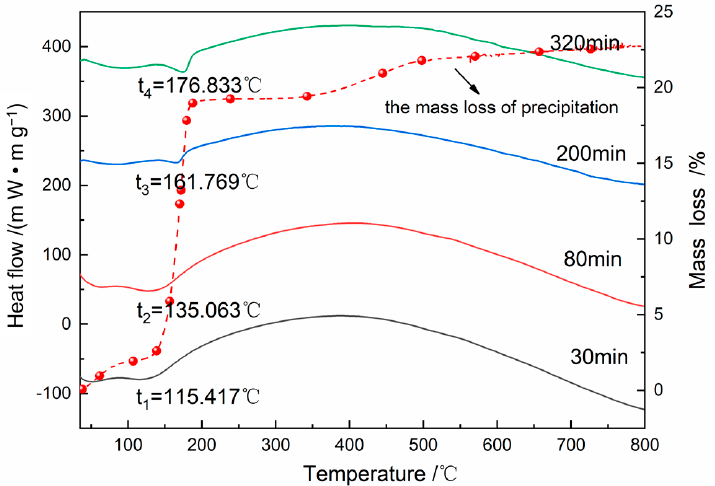
Figure 7. Heat-flow and mass change of precipitation at different reaction time during heating.